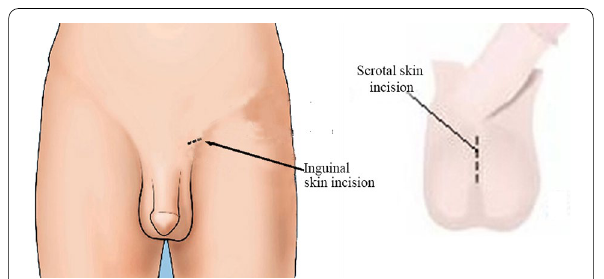
Fig. 2 The varicocele was clearly identified under the microscope at 10 power